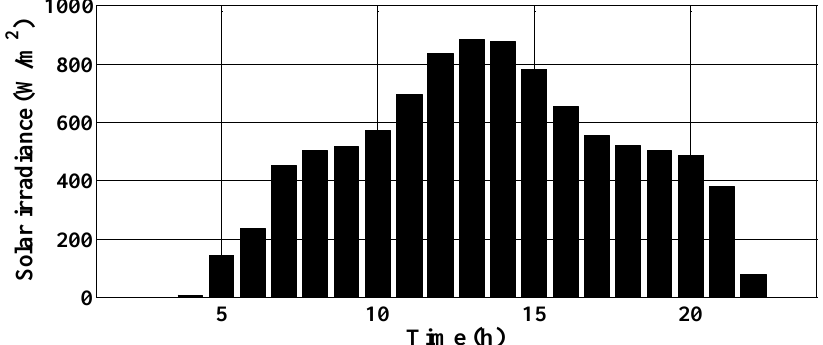
Figure 13. The forecasting solar irradiance.